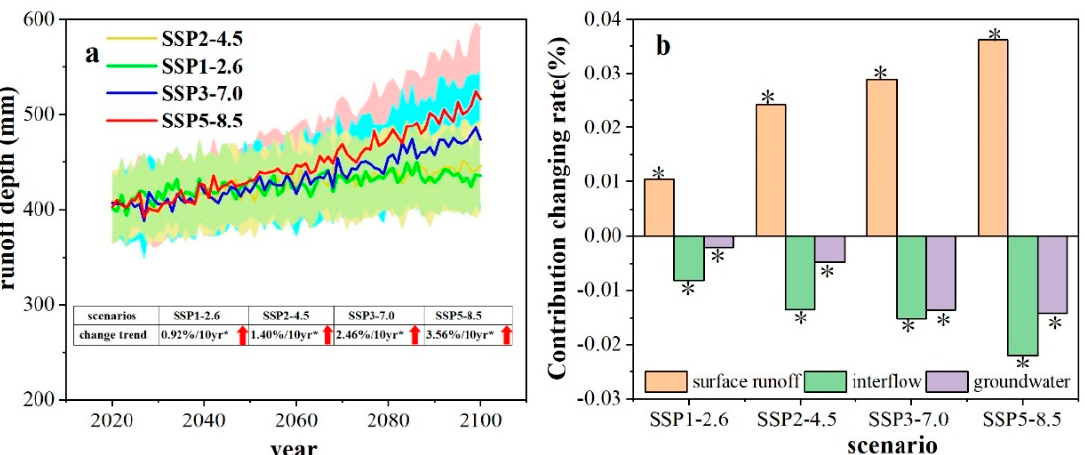
Figure 9. ( a ) Annual total runoff depth; and ( b ) rates of change in the contributions of surface runoff, interflow, and groundwater to total runoff during the 2020–2100 period in the study area under the four scenarios. *represents the significance at 0.05 level.